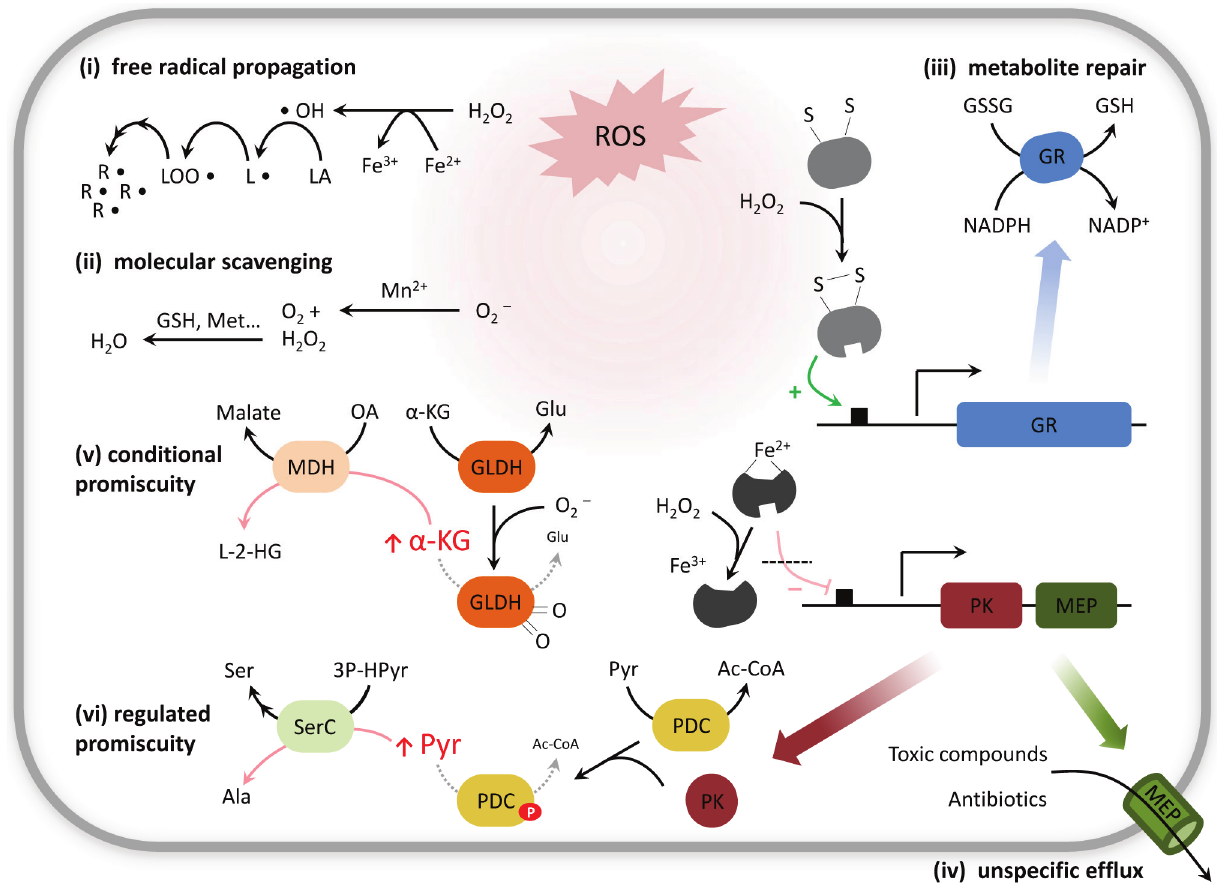
Figure 1. Formation of non-canonical metabolites and repair strategies. Chemical modification of metabolites leads to unwanted reactions, causing damage to both macromolecules and small molecules ( i ). Molecular scavengers cleanse and channel ROS toward less toxic products ( ii ). Stress sensors activate genes involved in specific protein-based repair responses ( iii ); or in unspecific transport processes ( iv ). As a general outcome, the metabolome reconfigures, affecting metabolite levels and fluxes; this in turn affects the specificity of enzymatic reactions. ( v – vi ) Selection of relevant examples from metabolism. Abbreviations: ROS, reactive oxygen species; Met, Methionine; GR, glutathione reductase; GSSG, oxidized glutathione or glutathione disulfide; GSH, reduced glutathione; MEP, multidrug efflux pump; LA, lipid; L•, lipid radical; LOO•, lipid peroxyl radical; R• complex radicals; GLDH, glutamate dehydrogenase; (cid:3)-KG, (cid:3)-ketoglutarate; Glu, glutamate; MDH, malate dehydrogenase; OA, oxaloacetate; L -2-HG, L -2-hydroxyglutarate; PK, protein kinase; PDC, pyruvate dehydrogenase complex; Pyr, pyruvate; Ac-CoA, acetyl-coenzyme A; SerC, phosphoserine transaminase; 3P-HPyr, 3-phosphohydroxypyruvate; Ser, serine; Ala,